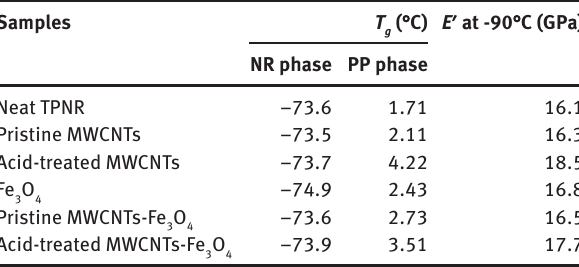
Table 3 Dynamic mechanical parameters of the neat TPNR and its nanocomposites at 1